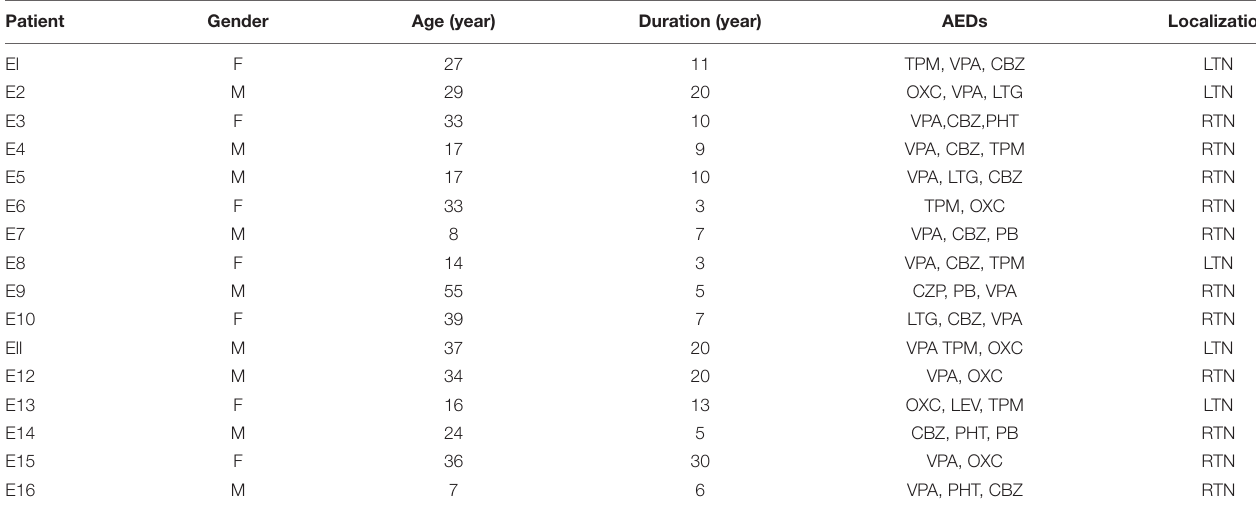
TABLE 1 | Clinical features of patients with drug resistance